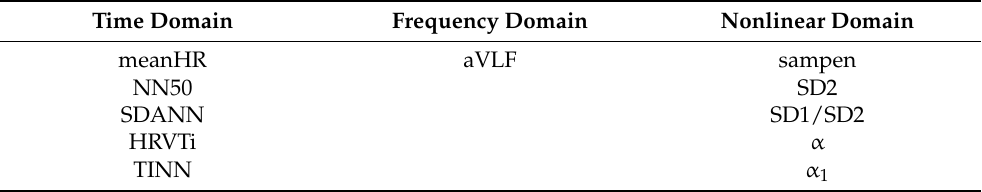
Table 5. Optimal feature set.